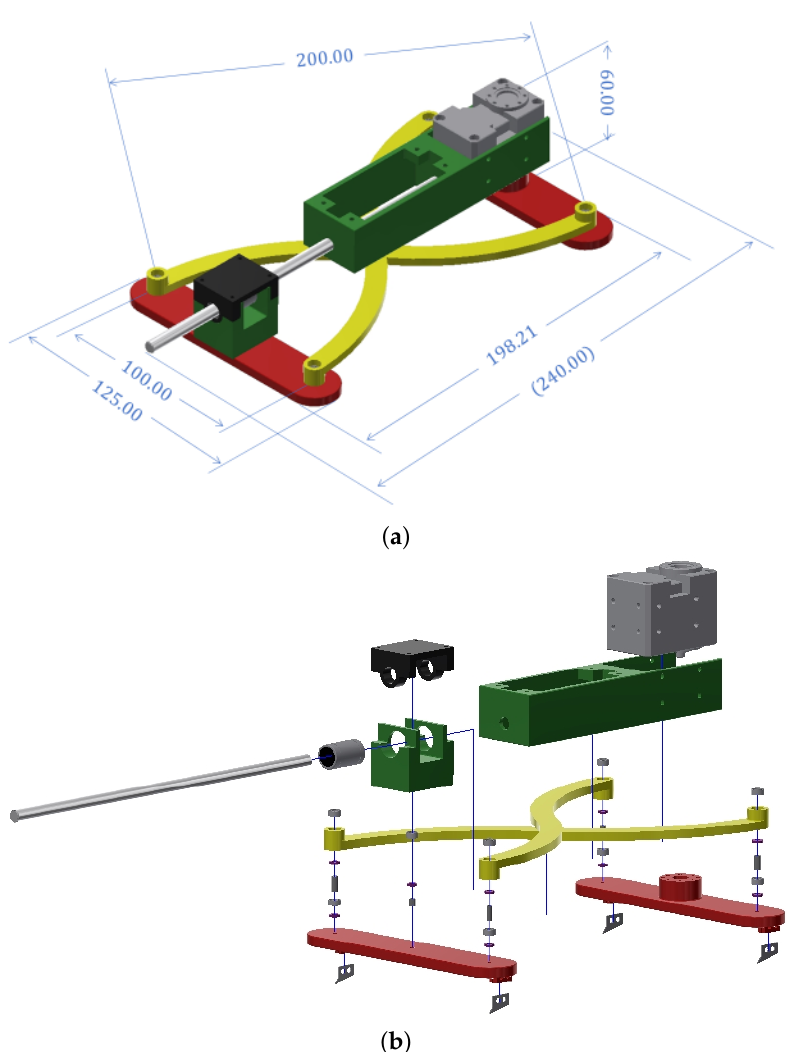
Figure 14. The CAD design of the robot: ( a ) the CAD design and dimensions; ( b ) the developmental diagram.